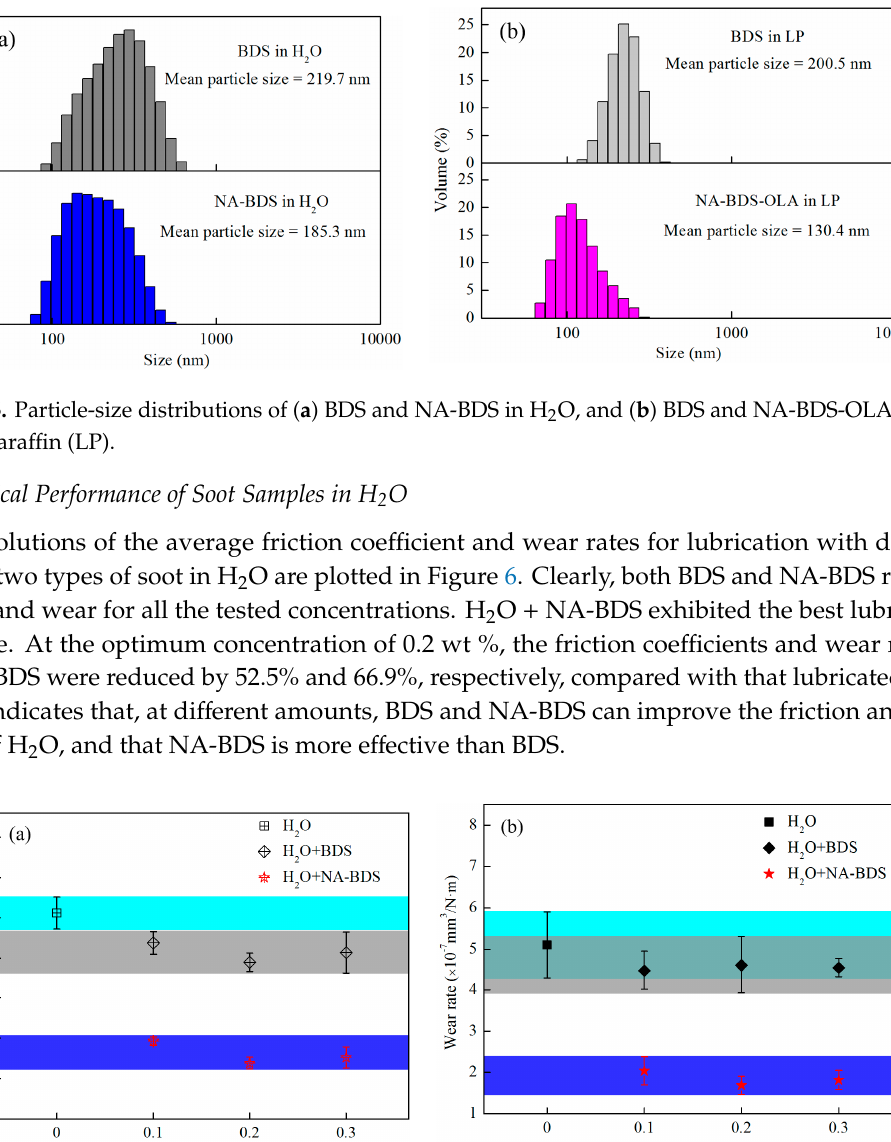
Figure 5. Particle-size distributions of ( a ) BDS and NA-BDS in H 2 O, and ( b ) BDS and NA-BDS-OLA in liquid paraffin (LP).